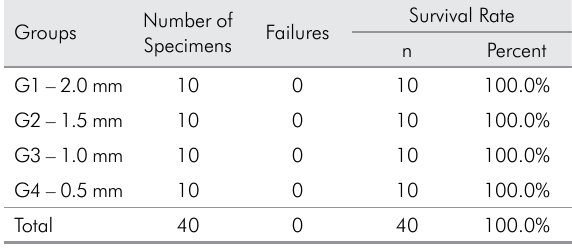
table 2. Test groups, number of specimens, number of fail- ures and specimen survival rate.